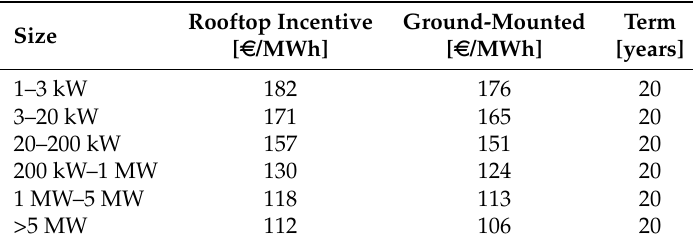
Table 1. Standard feed-in tariff established in